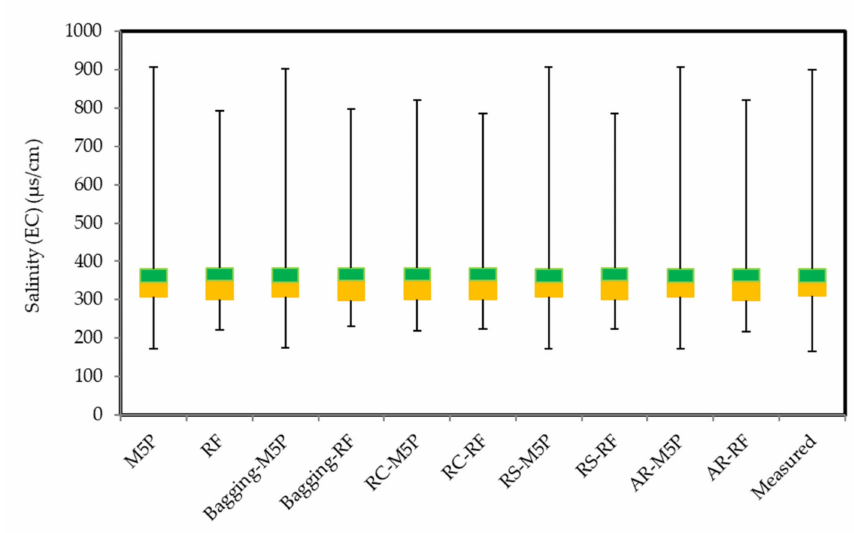
Figure 5. Box plot of predictions used for model evaluation in the testing phase.